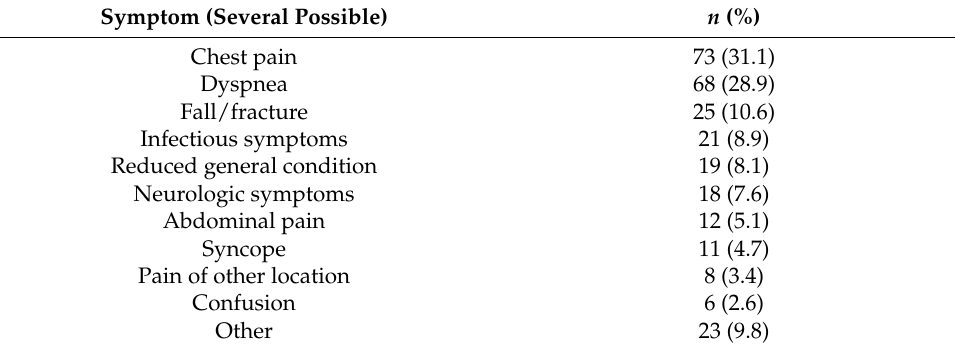
Table 1. Causes of hospital admission among non-CD patients.